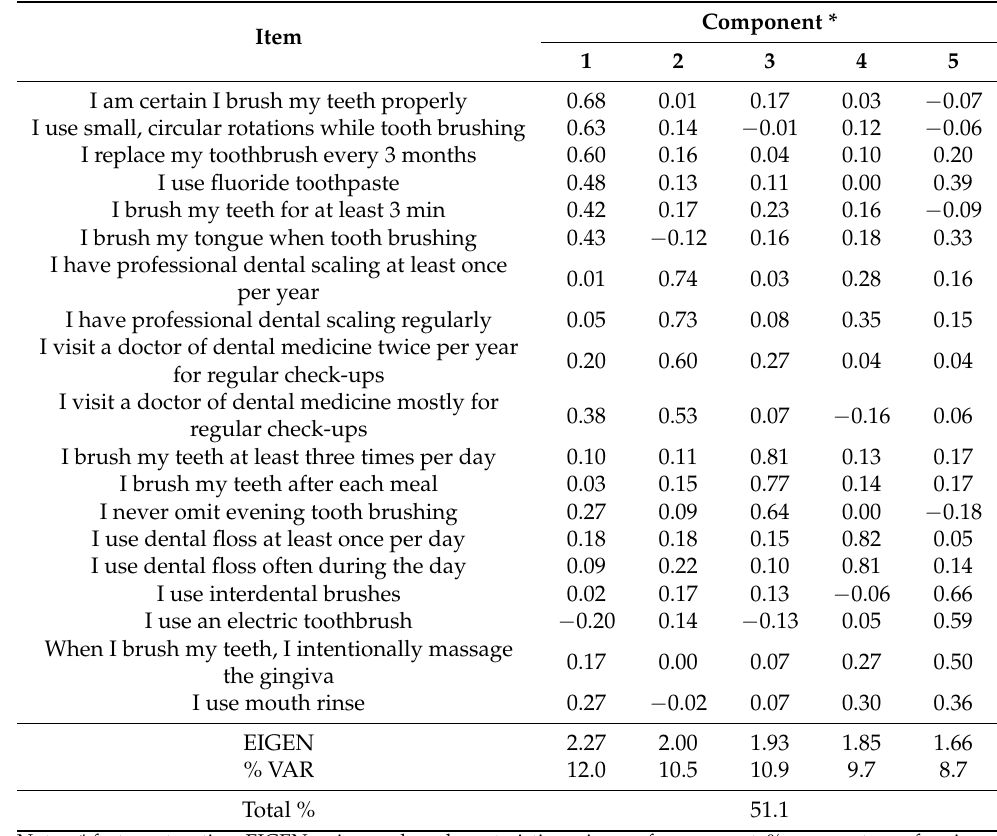
Table 1. Factor analysis of the Oral Health Activities Questionnaire items.